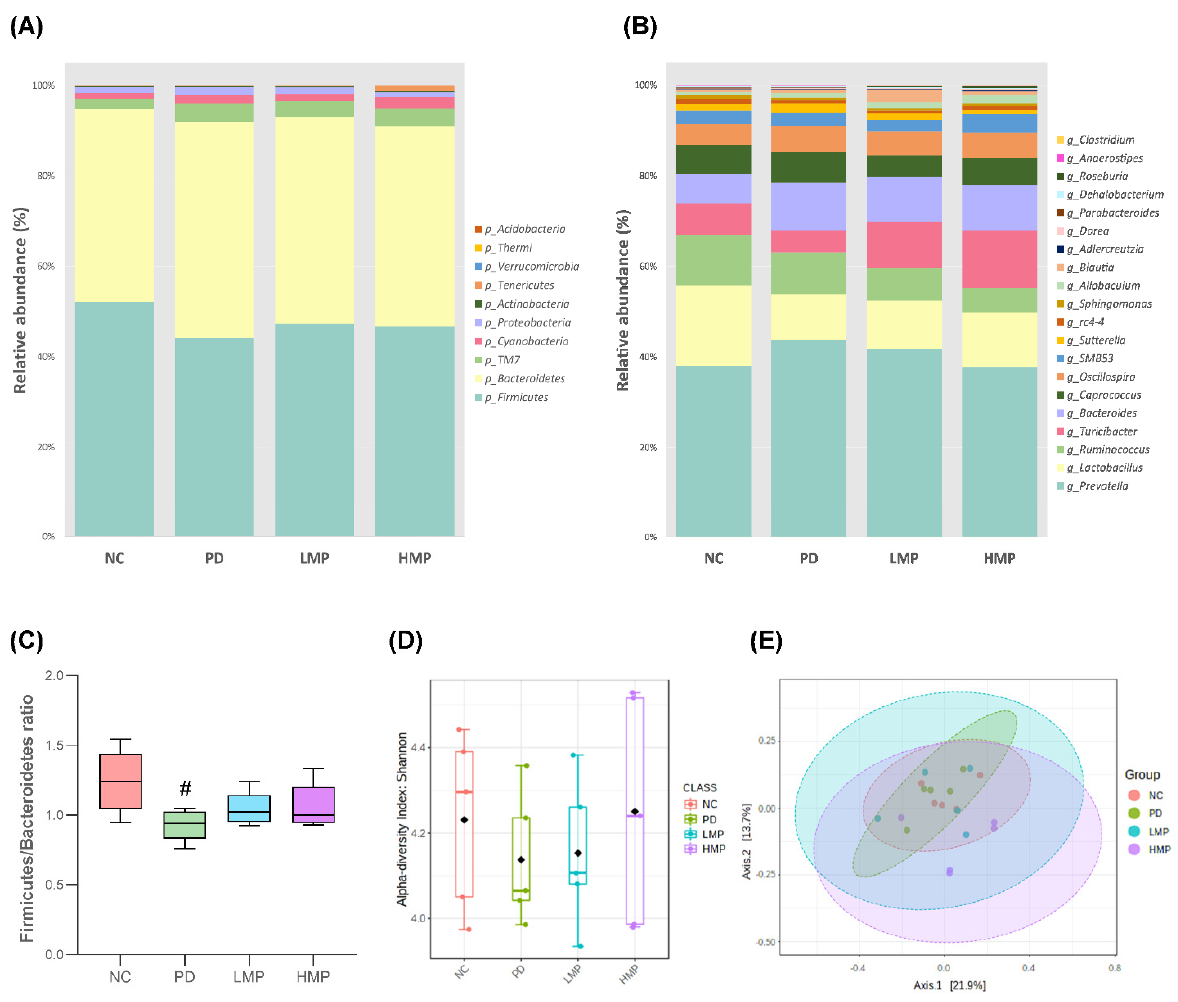
Figure 6. Comparison of the relative bacterial abundances and analysis of bacterial diversity based on 16S sequencing analysis of fecal samples after 8 weeks of supplementation in the rat model of PD. ( A ) Distribution of the top ten most abundant bacteria at the phylum level across all groups. ( B ) Distribution of the top twenty most abundant bacteria at the genus level across all groups. ( C ) Firmicutes to Bacteroidetes ratios of each group. # p < 0.05 for the Parkinson’s disease (PD) group vs. the normal control (NC) group. ( D ) Analysis of alpha diversity based on the Shannon index. ( E ) Analysis of beta-diversity based on principal coordinates analysis (PCoA) of the Bray–Curtis index. The ellipses illustrate 95% confidence intervals for the normal control (NC) versus Parkinson’s disease (PD) versus low-dose mangosteen pericarp (LMP) versus high-dose mangosteen pericarp (HMP).